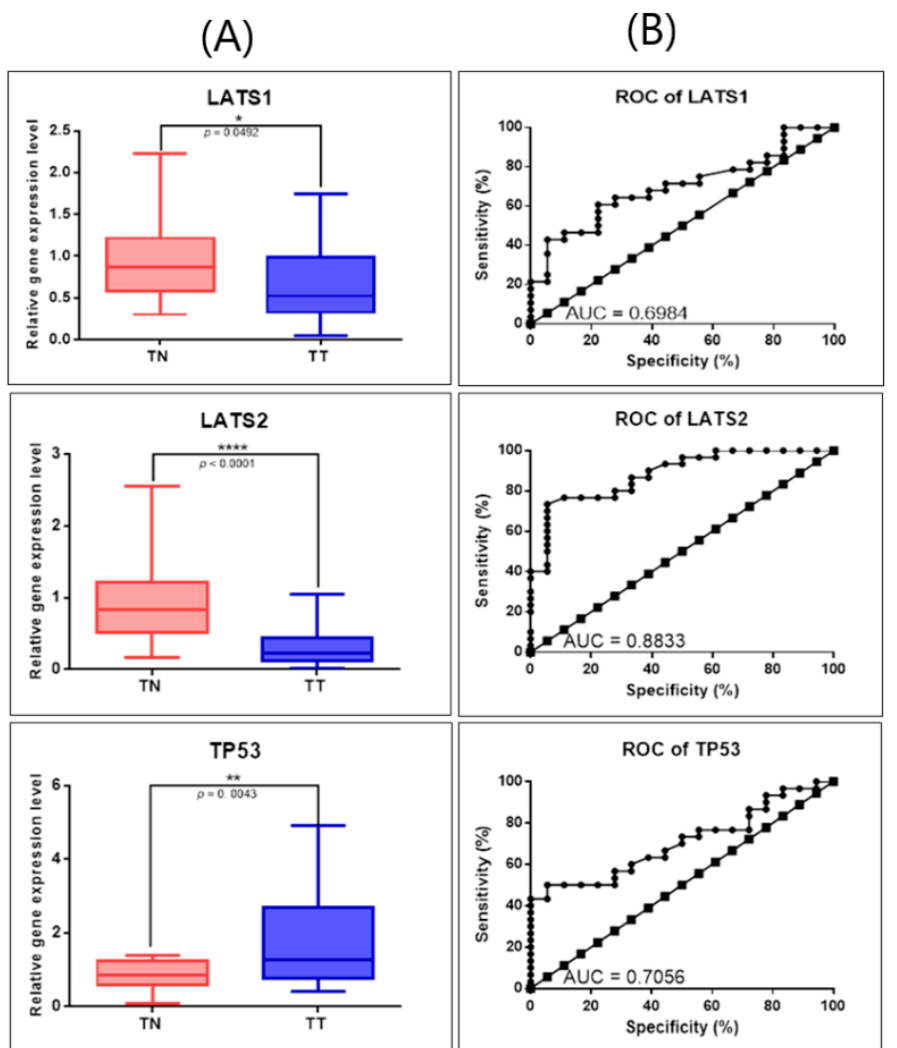
Figure 7. Gene expression alterations in OC evaluated by qRT-PCR. ( A ) Scatter plots demonstrating the downregulation of LATS1 and LATS2 and upregulation of TP53 in tumor tissues (TT, n = 30) versus normal tissues (TN, n = 22). For normalization of the gene expression data, we used B2M as internal control (* p ≤ 0.05, ** p ≤ 0.01, **** p ≤ 0.0001); ( B ) ROC curves for each selected gene’s specificity and sensitivity (ROC: receiver-operating characteristic, AUC: area under ROC curve).